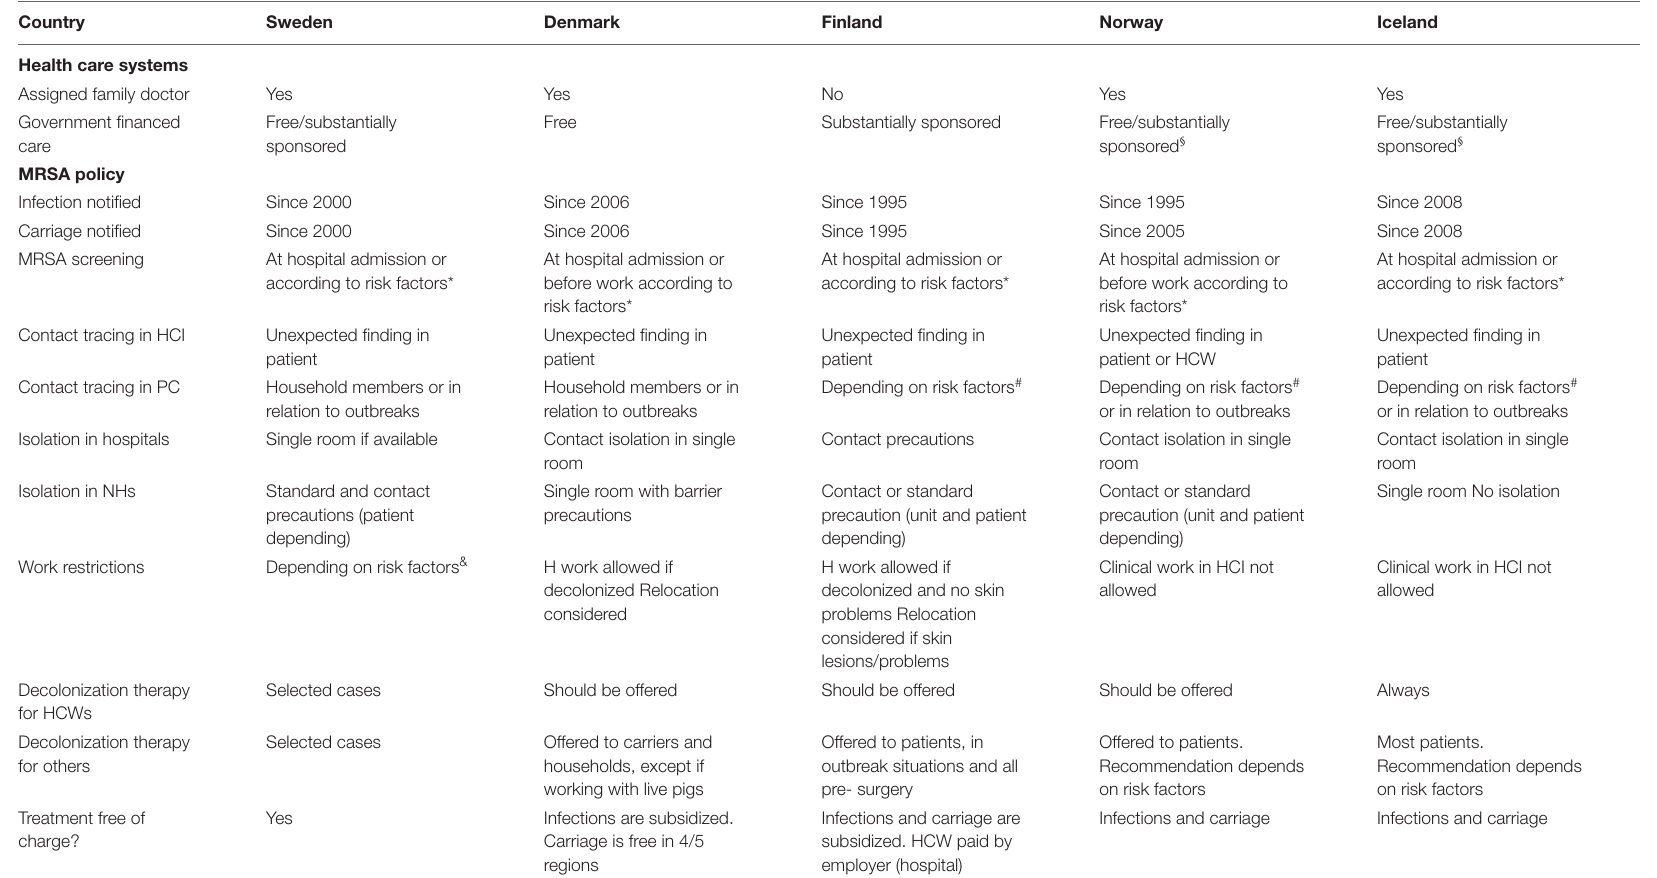
TABLE 1 | Health care systems and MRSA policy in the Nordic countries.